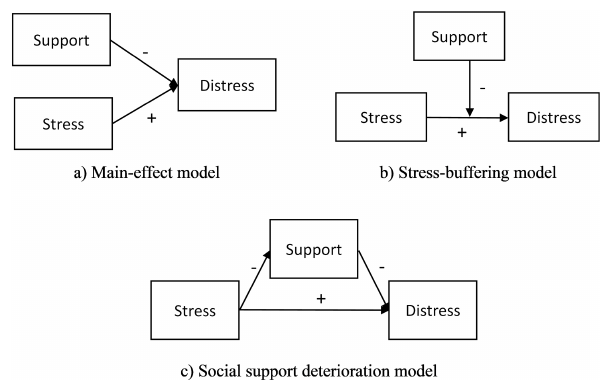
Figure 1. Different models of the relationship between social sup- port and mental health outcomes: (a) main-effect model, (b) stress- buffering model and (c) social-support deterioration